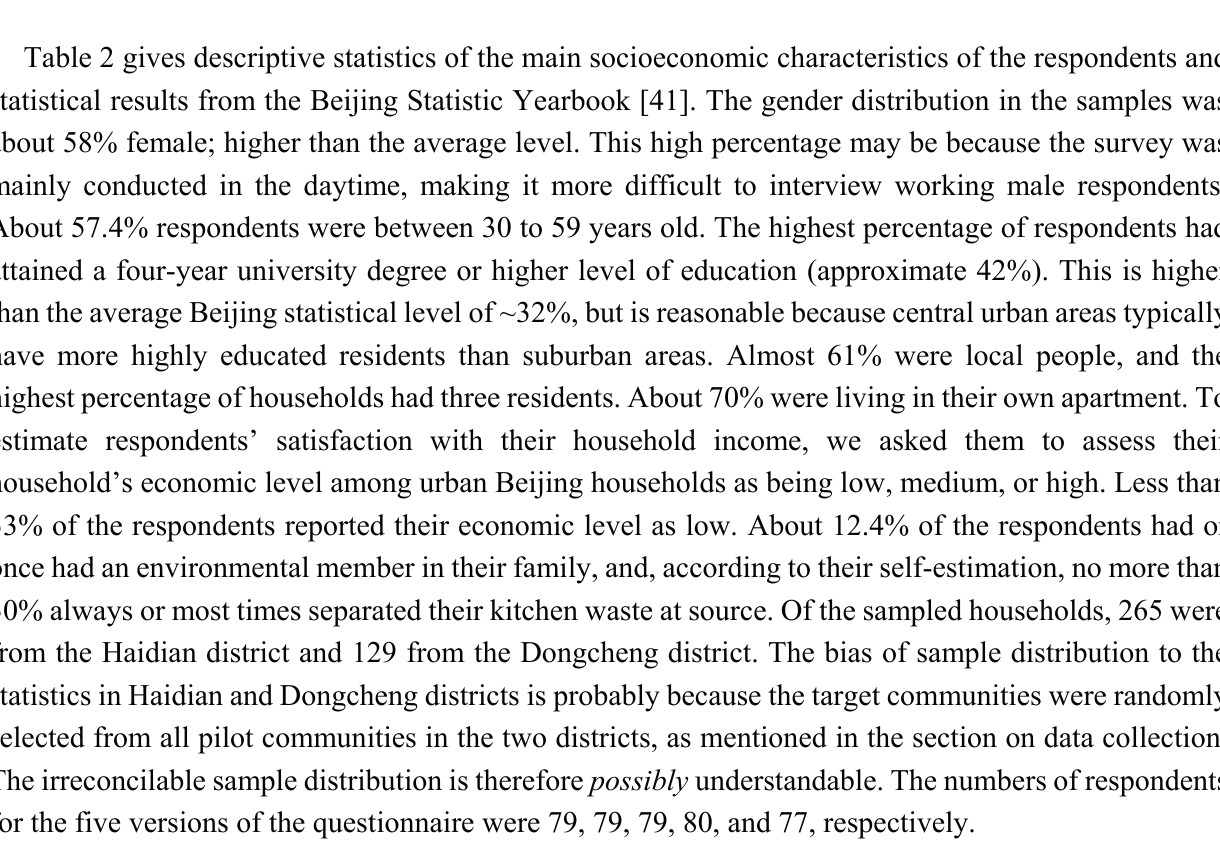
Figure 2. Beijing map and survey area (Source: Google